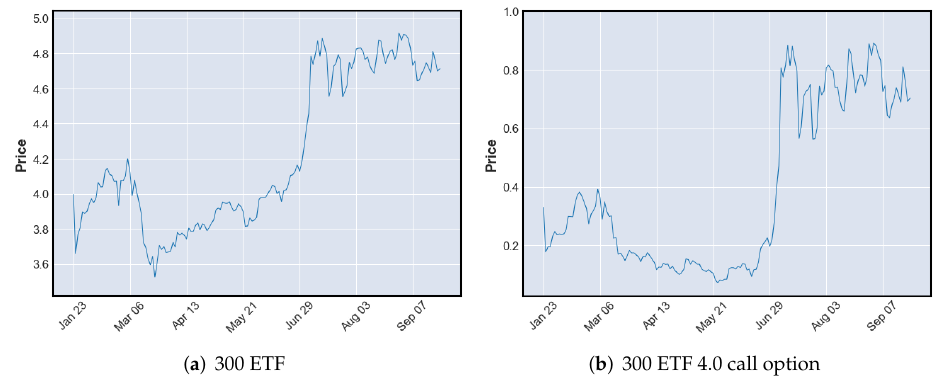
Figure 2. Price trend from 23 January 2020 to 23 September